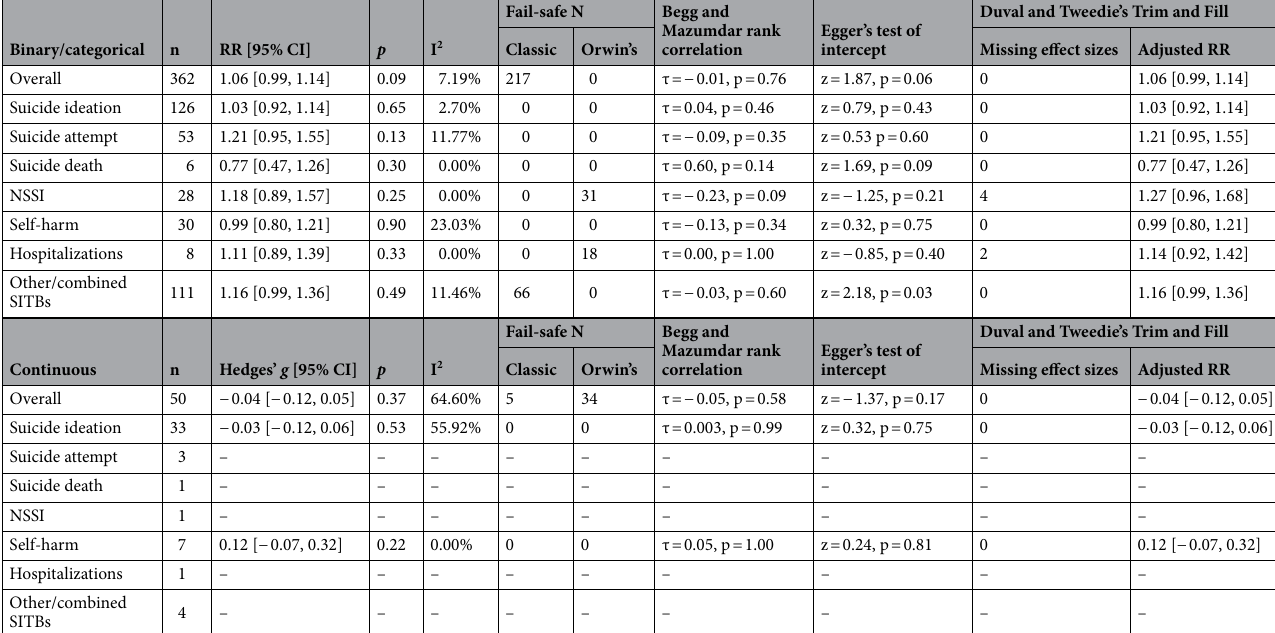
Table 2. Effect sizes and publication bias across SITB outcomes. n number of effect sizes, RR weighted mean risk ratio, CI confidence interval, dashes indicate unavailable information; I 2 indicates the percentage of variances due to heterogeneity between studies. Classic Fail-safe N and Orwin’s Fail-safe N represent the number of studies needed to nullify the observed effects statistically and clinically, respectively; Begg and Mazumdar Rank Correlation Test computes the rank order correlation between effect estimates and sampling variance; Egger’s Test of the Intercept uses precision (i.e., the inverse of the standard error) to predict the standardized effect (i.e., effect size divided by the standard error); Duval & Tweedie’s Trim & Fill estimates effect sizes after accounting for publication bias. Missing cases are the number of cases estimated to be missing below the mean. Boldface indicates significance at p <